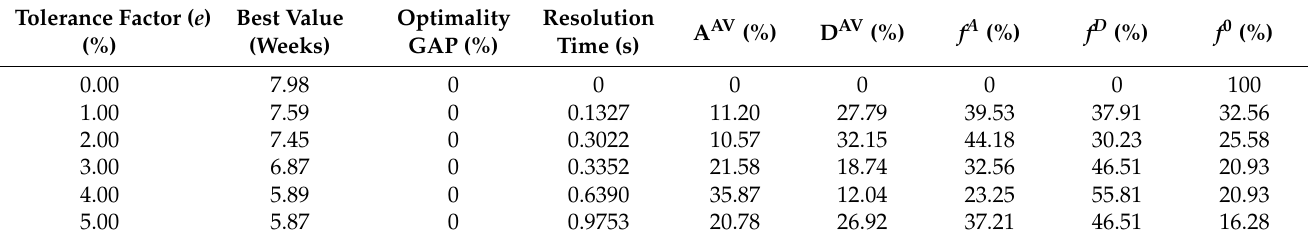
Table 4. Performance indicators for instances under several tolerance factors.